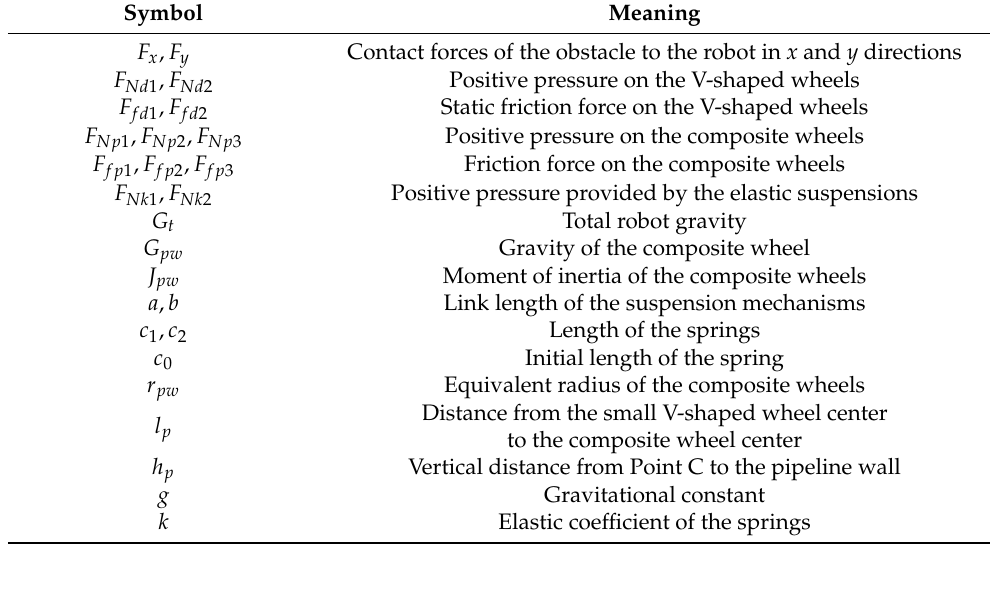
Table 2. Parameters in the force analysis.